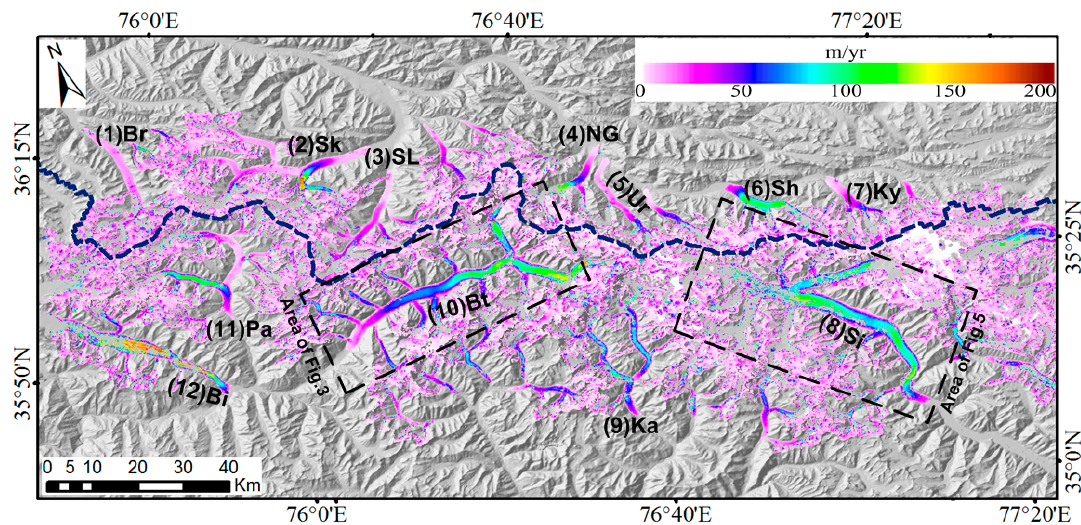
Figure 2. Average annual velocity field across the Central Karakoram from 1999–2003. The background is the hillshade image of SRTM DEM. The blue dashed line marks the boundary between the southern and northern slopes’ glaciers. Abbreviations: Br = Braldu Glacier, Sk = Skamri Glacier, SL = Sarpo Laggo Glacier, NG = North Gasherbrum Glacier, Ur = Urbak Glacier, Sh = Singkhu Glacier, Ky = Kyagar Glacier, Si = Siachen Glacier, Ka = Kaberi Glacier, Bt = Baltoro Glacier, Pa = Panmah Glacier, Bi = Biafo Glacier.